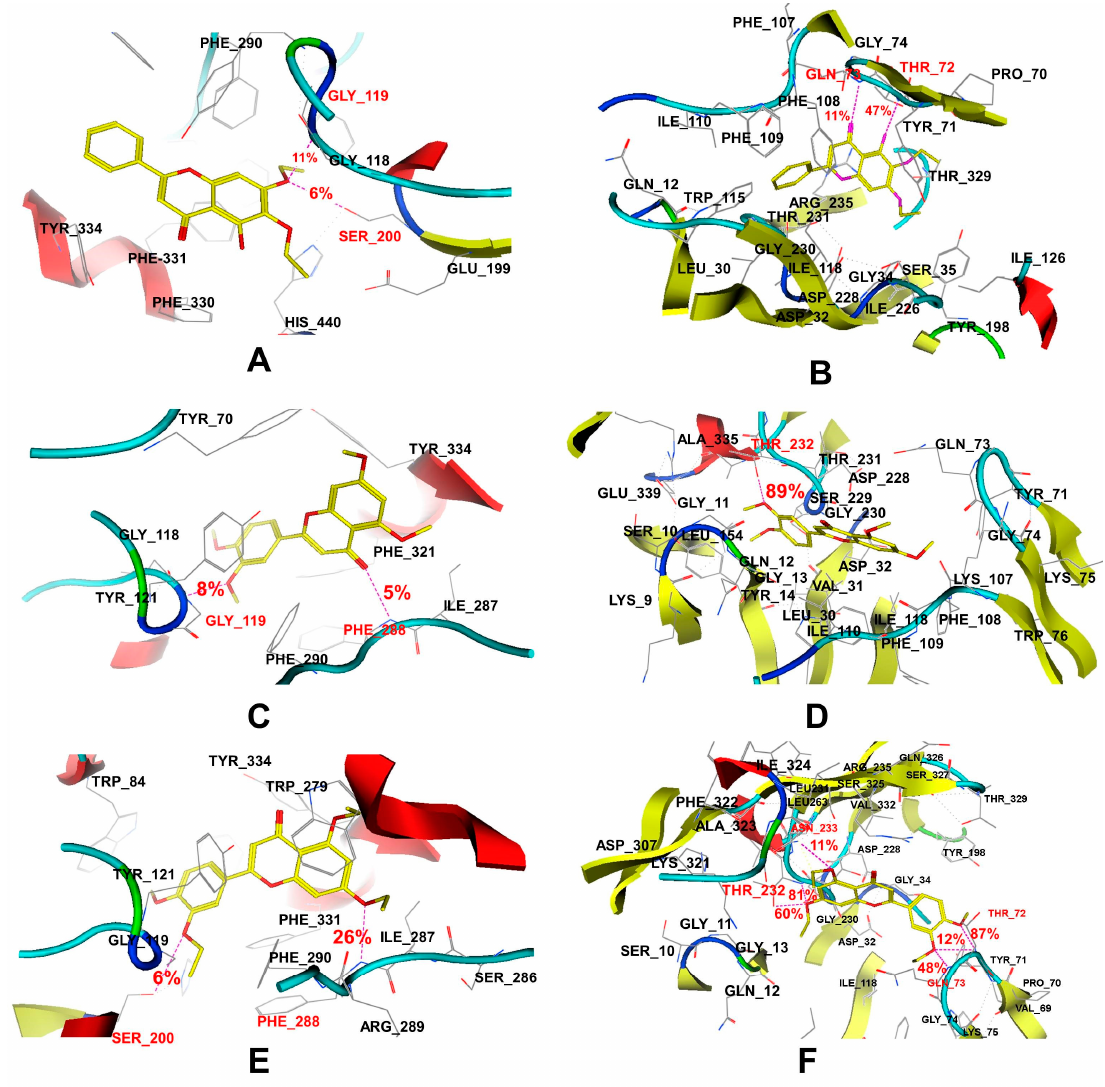
Figure 3. Interactions with AChE (left) and BACE-1 (right) of flavone derivatives B3 ( A , B ), D5 ( C , D ) and D6 ( E , F